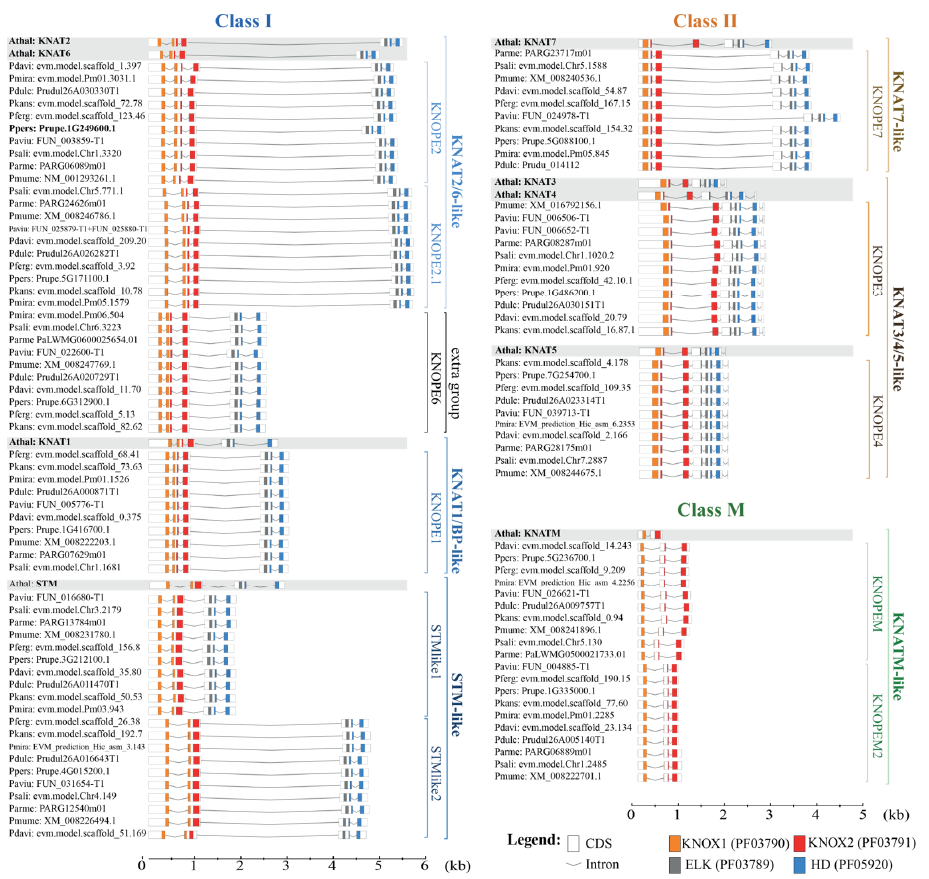
Figure 3. Exon–intron structure and conserved motifs in PRUNOX genes. The organization of each class was compared to A. thaliana counterparts (grey-shaded). Boxes, coding sequences; gray lines, introns. KNOX conserved motifs are colored.